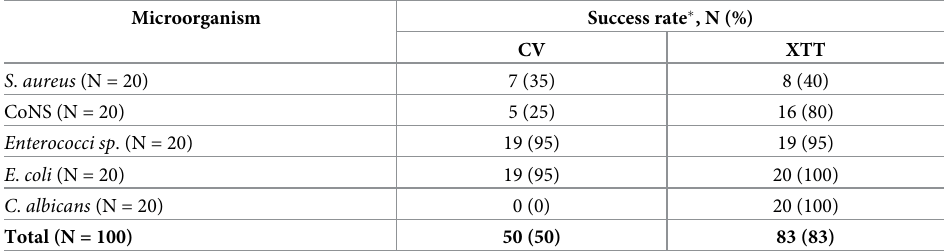
IU; international units; CV , crystal violet; XTT, 2,3-Bis-(2- methoxy 4-nitro-5-sulfophenyl)-2H- tetrazolium5-carboxanilide salt; CoNS , coagulase-negative staphylococci. � Success rate was set as �